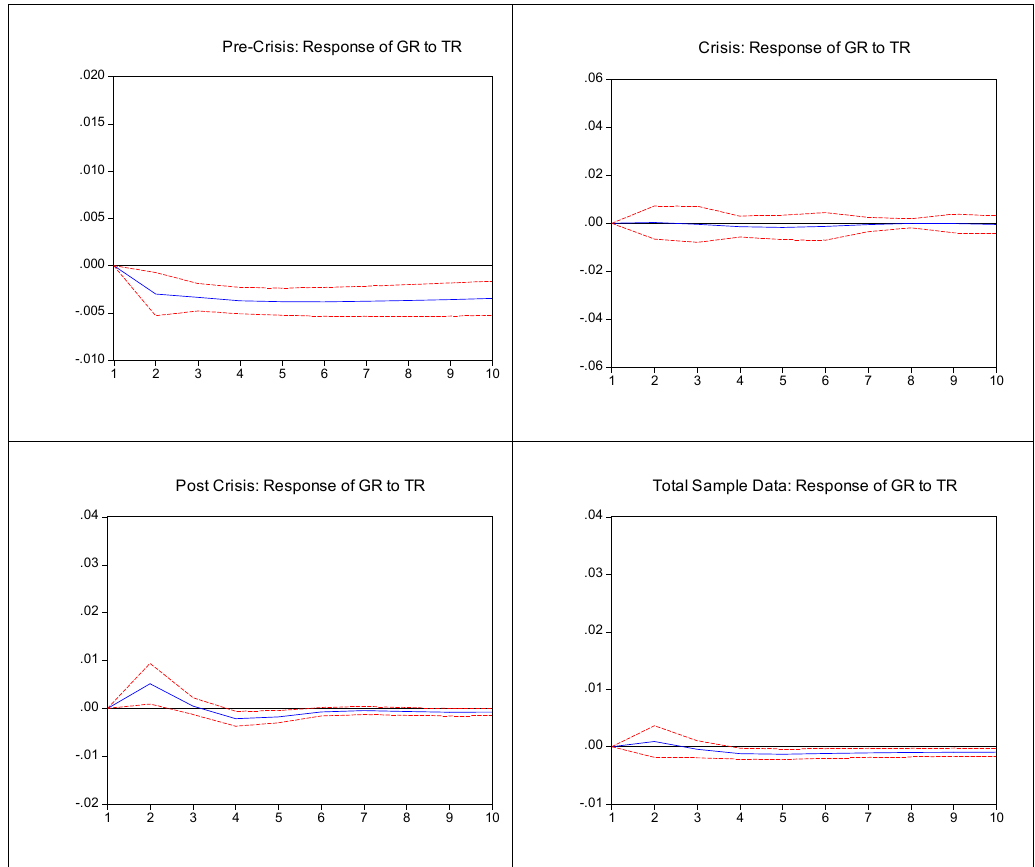
Figure 1. Impulse Response Functions of GR and TR: Pre-Crisis, Crisis, Post Crisis and Full Sample